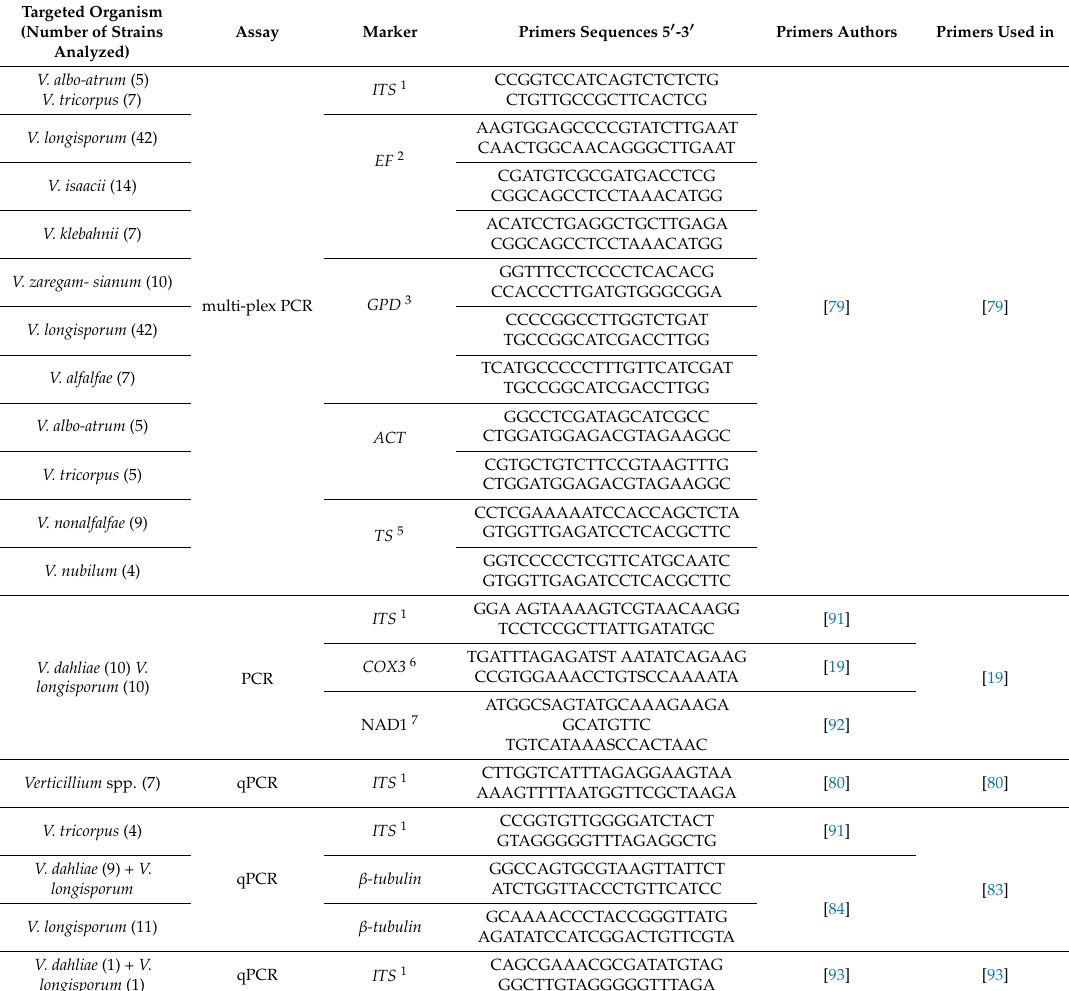
Table 2. Selected primers designed for molecular analysis of Verticillium